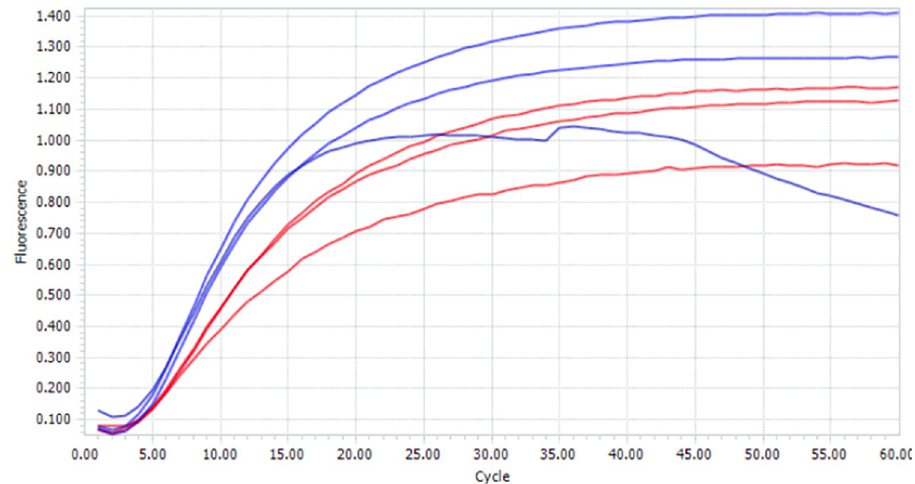
Fig 14. Amplification curves obtained using the LightCycler96 for RCA amplification in droplets. Fluorescence detection (EvaGreen 1 ) is acquired after each two step cycle [37˚C for 30 seconds—37˚C for 30 seconds followed by aquisition] x 60 cycles. Blue lines correspond to the reaction that was not emulsified. Red lines correspond to the emulsified reaction. Assays done by triplicate.